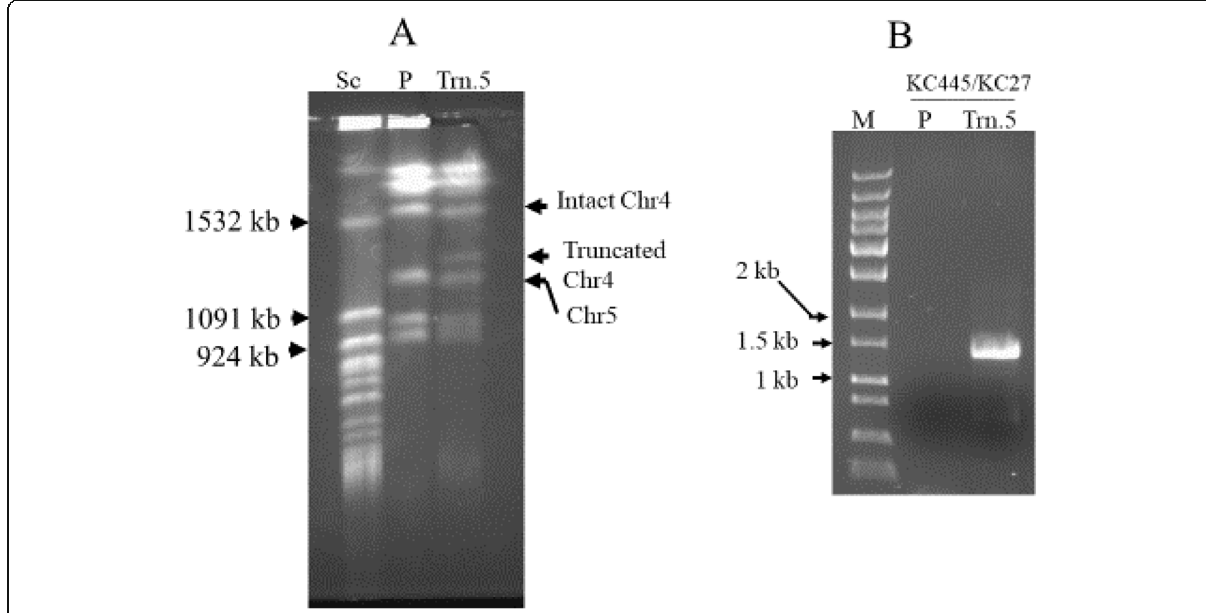
Fig. 5 Verification of truncation 5 on chromosome 4. A Karyotypic verification using CHEF. Sc, S. cerevisiae chromosomes size marker, three relevant chromosome sizes are indicated by arrows at 1532 kb, 1091 kb, and 924 kb respectively; P, wild type strain CAF4-2; Trn.5, chromosomes of the strain carrying truncation 5 at 1301.783 kb position on Chr4. The size of the truncated version of Chr4 (~ 1305 kb) is approximately 300 kb shorter than intact Chr4 and runs above Chr5 (Chr5 size---1191 kb). B PCR verification of truncation 5 with specific primers KC445/KC27. Lane M, 1 kb DNA ladder; lane P, PCR for wild type strain (no PCR product amplified); lane Trn.5, PCR for truncation junction producing 1.5 kb PCR product (expected